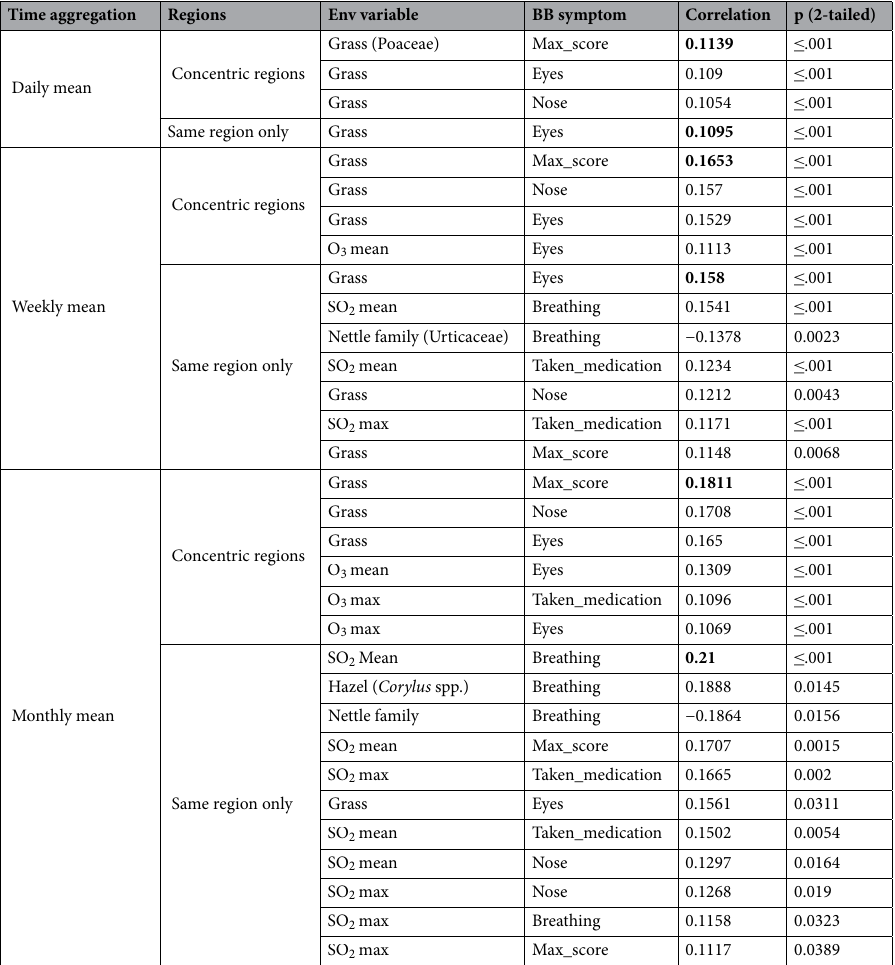
Table 5. Correlations of BB symptom scores with environment variables, grouped by postcode region. Only significant correlations (indicated by p values ≤ 0.05) are included here. Data is for March–Sept (inclusive). Highest results for each frequency/region type combination are highlighted in